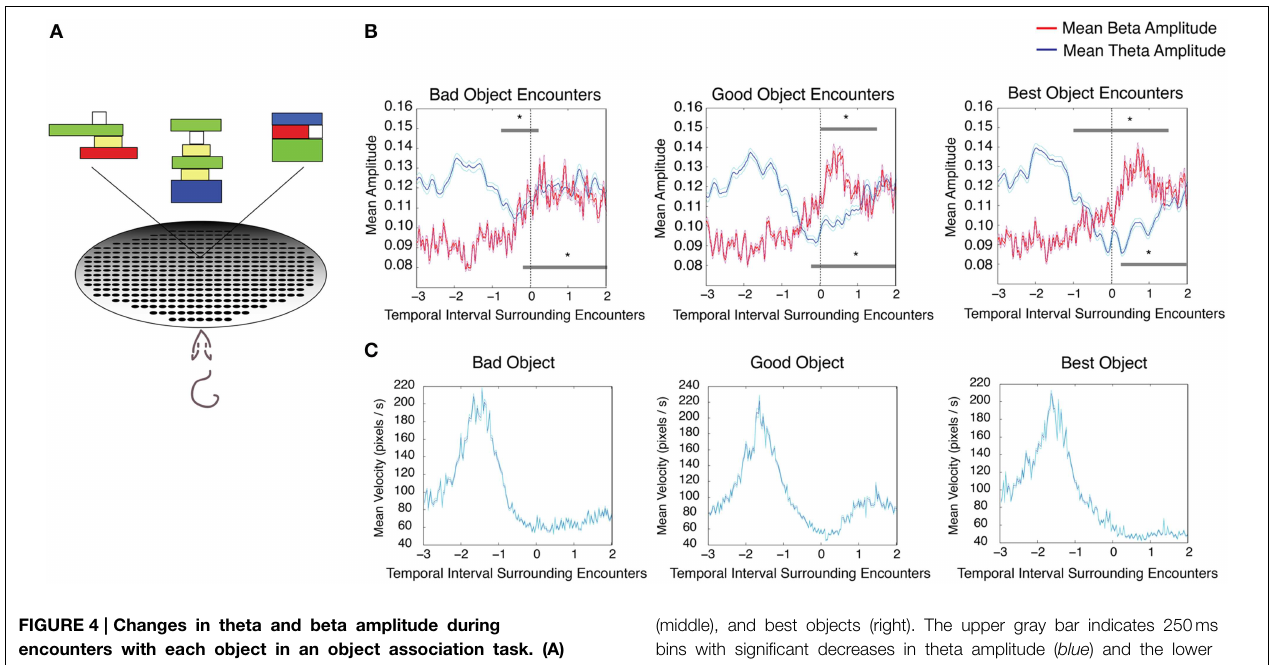
(middle), and best objects (right). The upper gray bar indicates 250ms bins with significant decreases in theta amplitude ( blue ) and the lower gray bar indicates 250ms bins with significant increases in beta amplitude ( red ). Error bars indicate standard error for theta ( cyan ) and beta ( magenta ) means. (C) Mean velocity during intervals surrounding object encounters in the object association task; significant via Tukey’s HSD, * p < 0 . 05